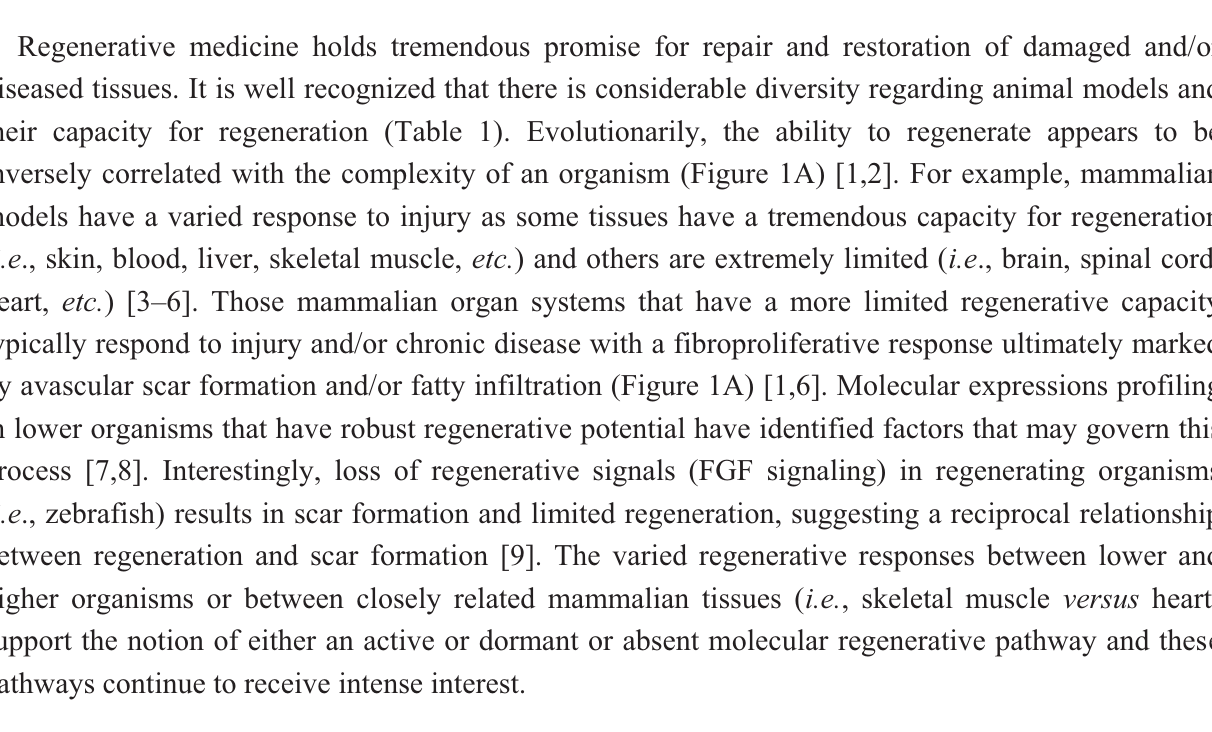
Table 1. Differential regenerative potential in